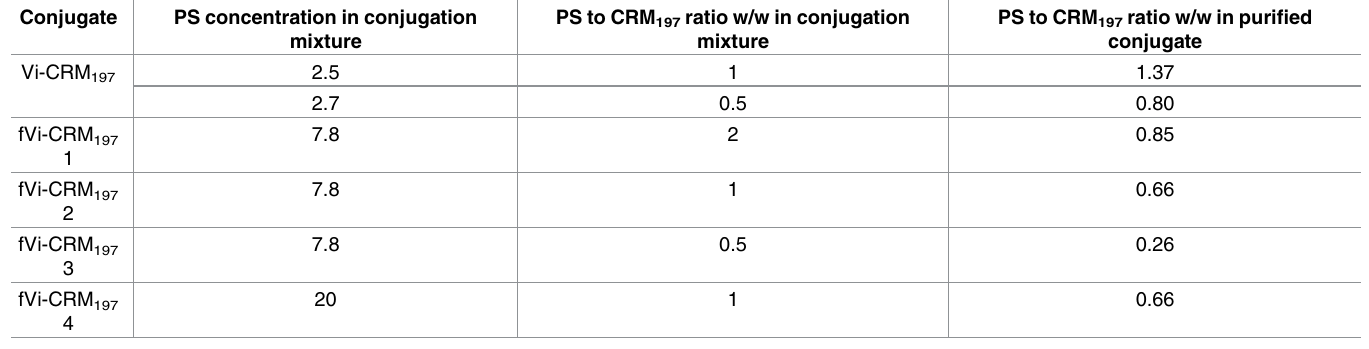
All purified conjugates showed less 20% free Vi and no detectable amounts of free